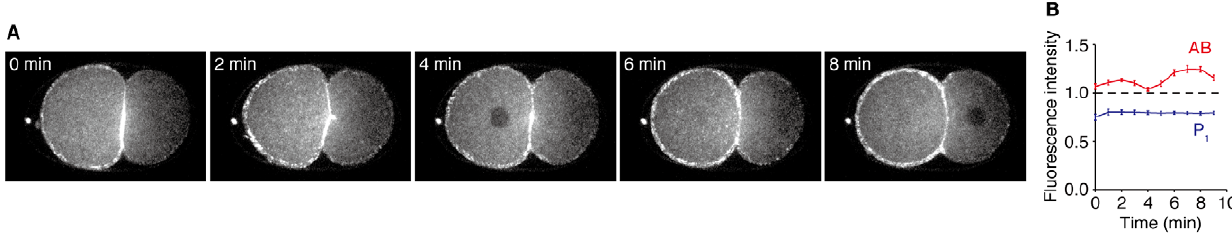
Figure 4. Dynamics of NMY-2::GFP in the two-cell stage embryos. (A) Z-stack projections from a time-lapse sequence of an embryo expressing NMY-2::GFP. The maximum intensity projection of four planes spanning 1.5 m m is shown. (B) Mean fluorescence intensity of NMY-2::GFP in AB and P 1 (n=12). Values normalized by the spatiotemporal average of both cells are shown. Error bars indicate s.e.m. Time is from the onset of the two-cell stage. doi:10.1371/journal.pone.0030224.g004 Figure 5E). In contrast, the AB cortex of irradiated P 1 embryos (733 6 28) and the P 1 cortex of irradiated AB embryos (443 6 20)